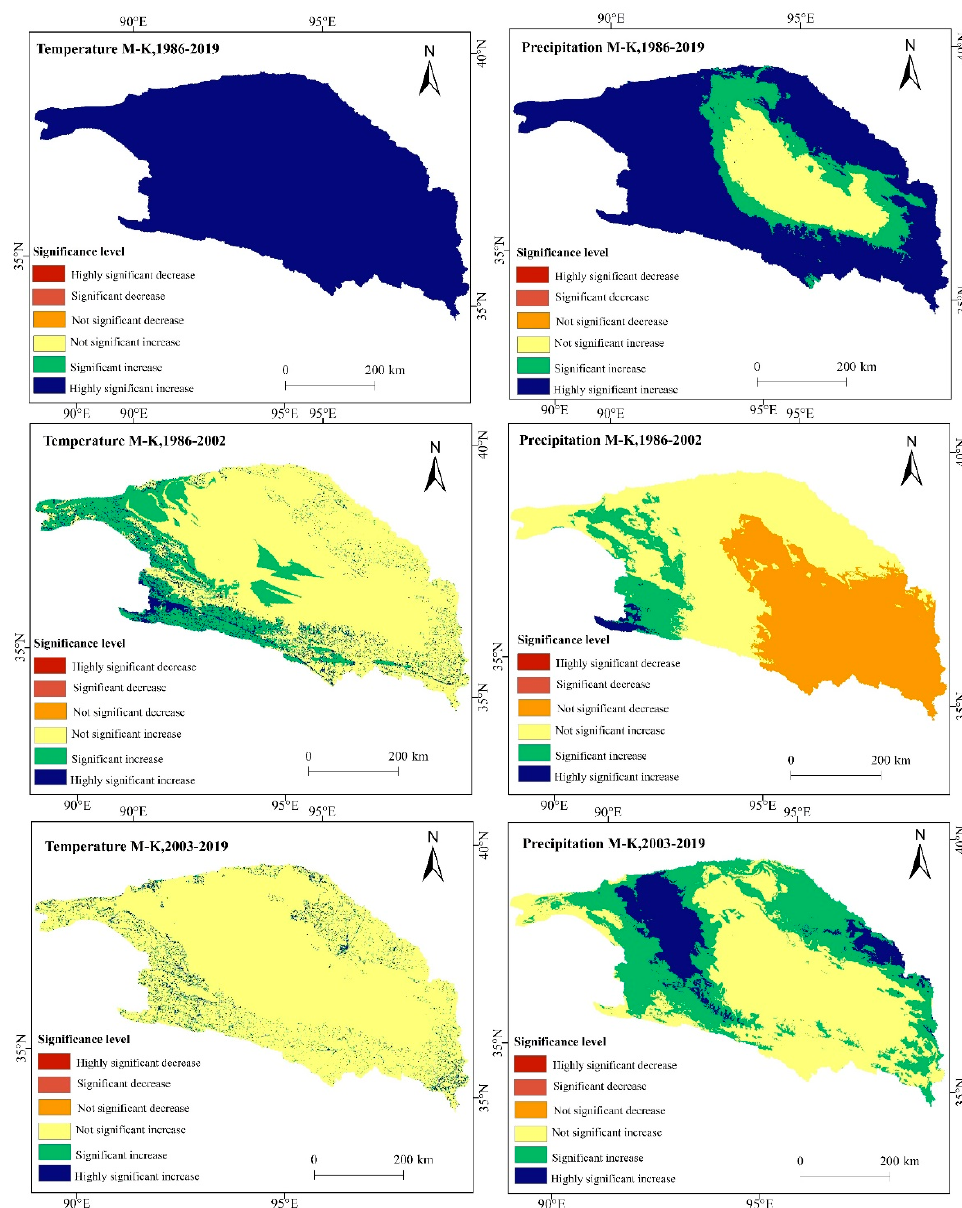
Figure 9. Spatial distribution of climate factor change in Qaidam Basin from 1986 to 2019. Table 6. Changing trends of the climate factors in Qaidam Basin from 1986 to 2019 (km 2 , %).